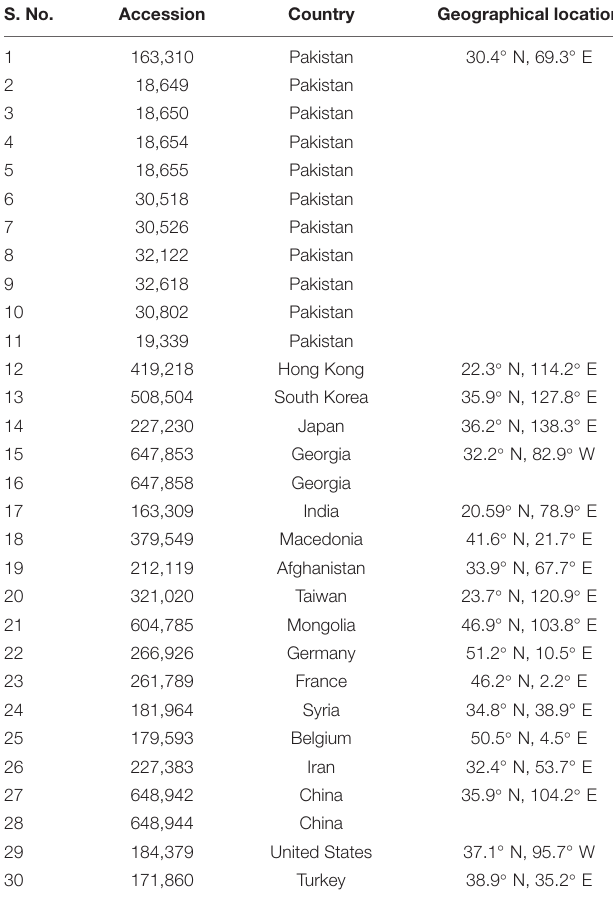
TABLE 1 | Geographical location of thirty spinach accessions for nutritional and genetic analyses. S.